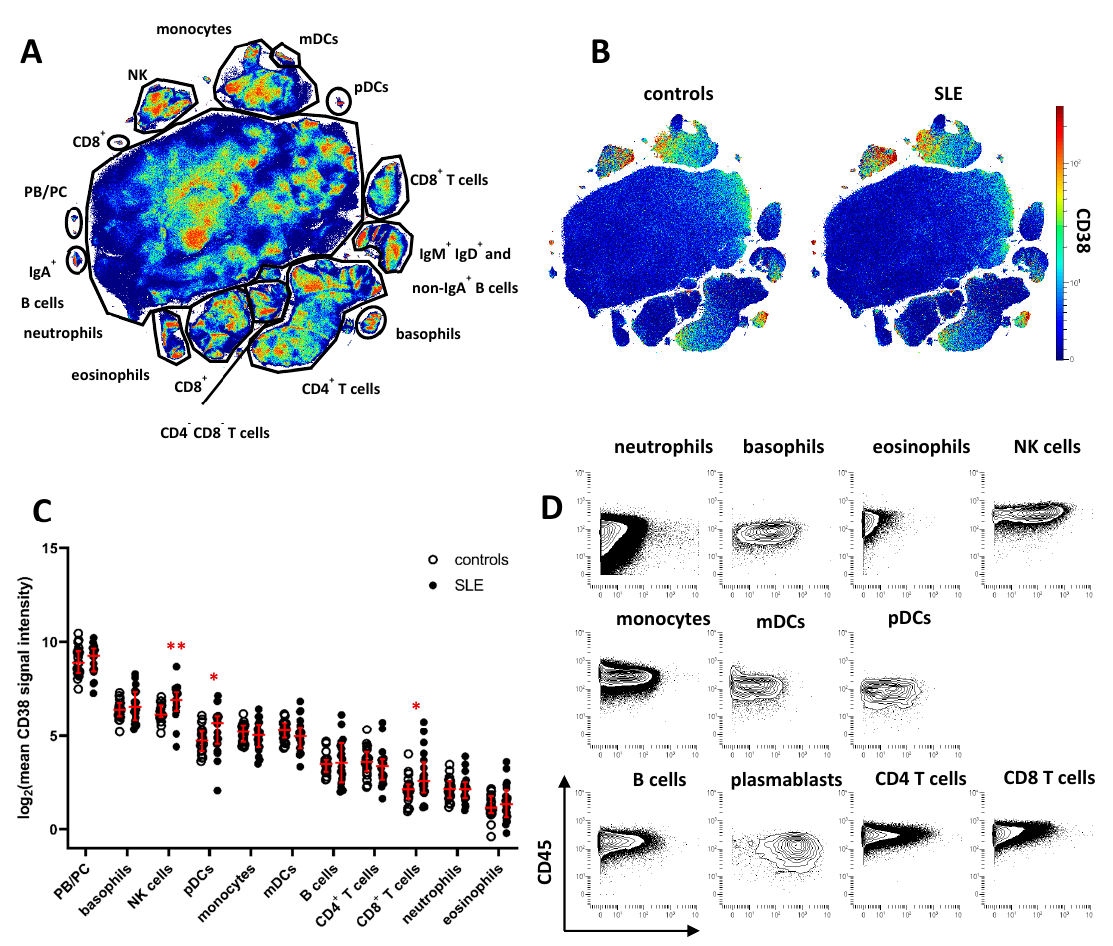
Figure 1. Cell type-specific dysregulation of CD38 expression in patients with SLE. Peripheral blood leukocytes from 20 SLE patients and 20 healthy controls were analyzed by mass cytometry. ( A ) t-SNE map showing all leukocytes analyzed in the study (7.6 × 10 6 cells). Major cell subsets were annotated. Color indicates cell density. ( B ) CD38 expression across major leukocyte subsets in SLE patients and controls. Concatenated data is shown for both groups. ( C ) Comparison of CD38 expression across major subsets gated in ( A ). Each dot represents the log 2 of mean CD38 signal intensity (SI) of the indicated subset of one donor. Red lines indicate median values and interquartile range. * indicate significantly different CD38 expression in SLE patients vs. controls revealed by Mann–Whitney testing (* p < 0.05; ** p < 0.01) ( D ) Contour plot representation of CD38 expression of the indicated leukocyte subsets. Concatenated data of 20 healthy controls are shown.